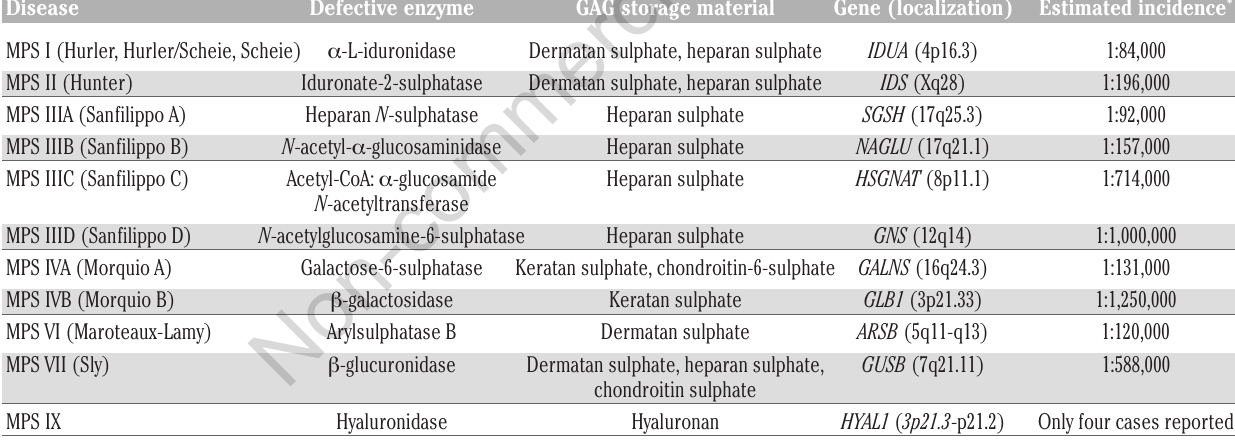
Table 1. Nomenclature and classification of mucopolysaccharidoses. Disease Defective enzyme GAG storage material